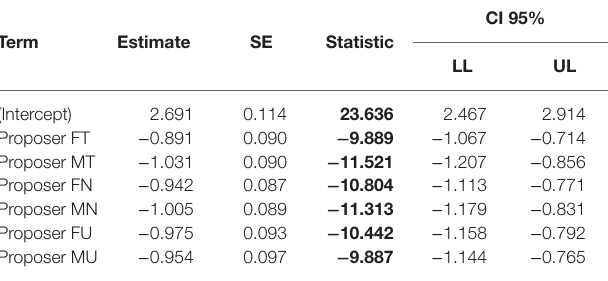
Significant results are in bold.